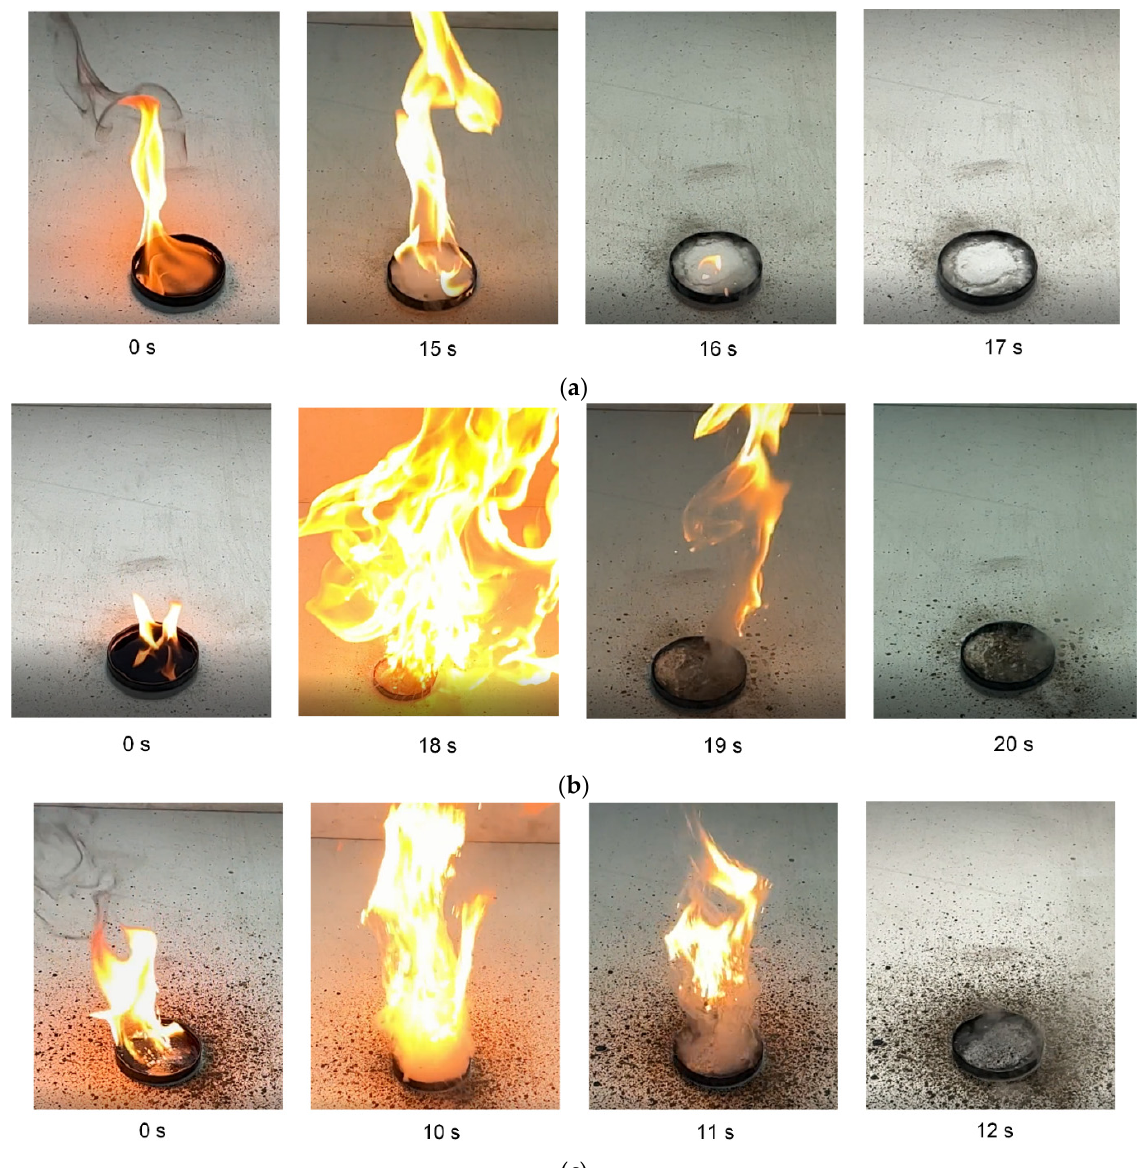
Figure 4. Images of flammable liquid fire suppression ( V 0 ≈ 3 mL) by carbon dioxide hydrate powder, m g ≈ 4 g: ( a ) kerosene; ( b ) motor oil; ( c ) crude oil ( d f ≈ 65 mm, S f ≈ 33 cm 2 ).